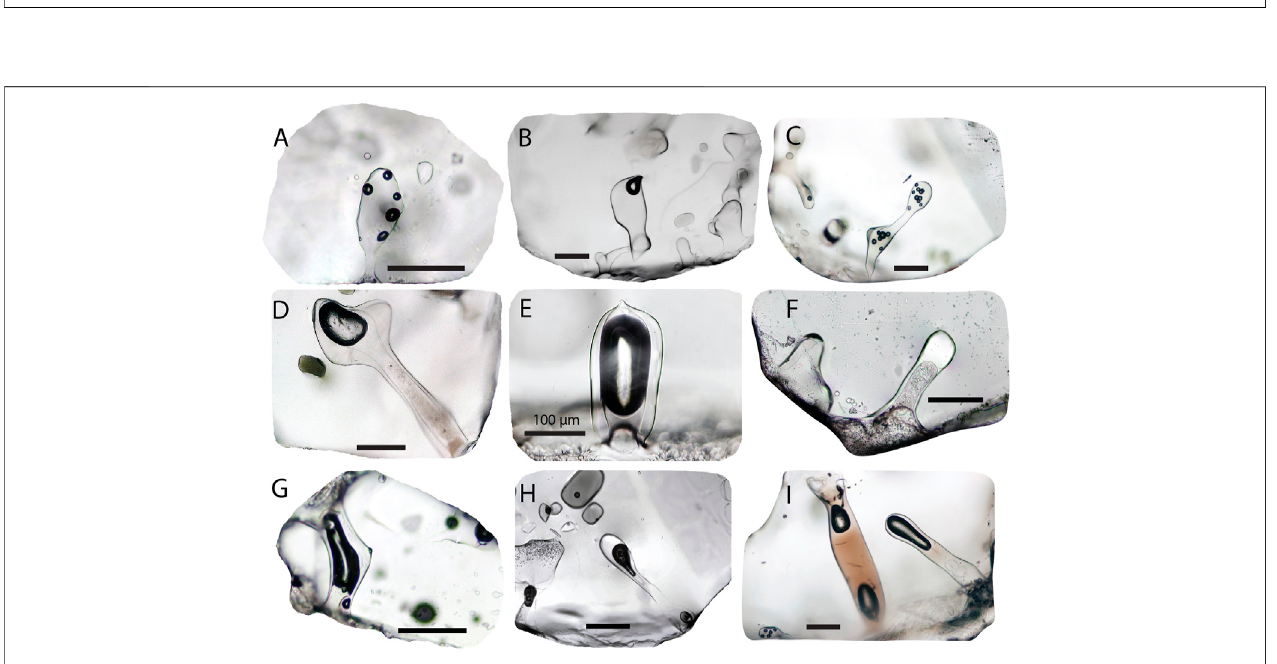
FIGURE7| Photomicrographsofembayment fi llingcharacteristictextures;discretefree- fl oatingbubblesoccurringin: (A) and (C) multiplesandasa (B) single,lone bubble; (D – F) intrudingbubbleswhichpenetratethefulllengthoftheembaymentglass.Someindexofrefractiondifferencesarecomplicatedbymineraloilpartially fi lling the intrudingbubble. (G – I) discrete elongatebubbles whicharesimilartointruding bubbles, yetarediscontinuousand truncateinsidetheembayment.Scalebar ineach panel is 200 µm unless indicated otherwise (E) .